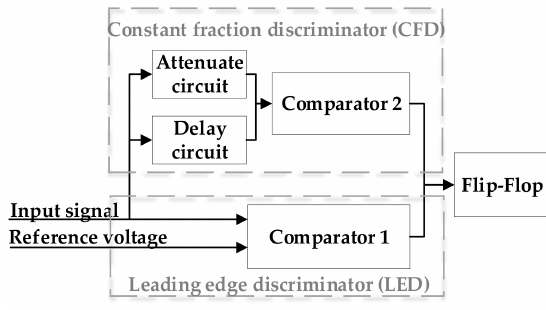
Figure 2. Time discriminator of constant fraction discriminator circuits.